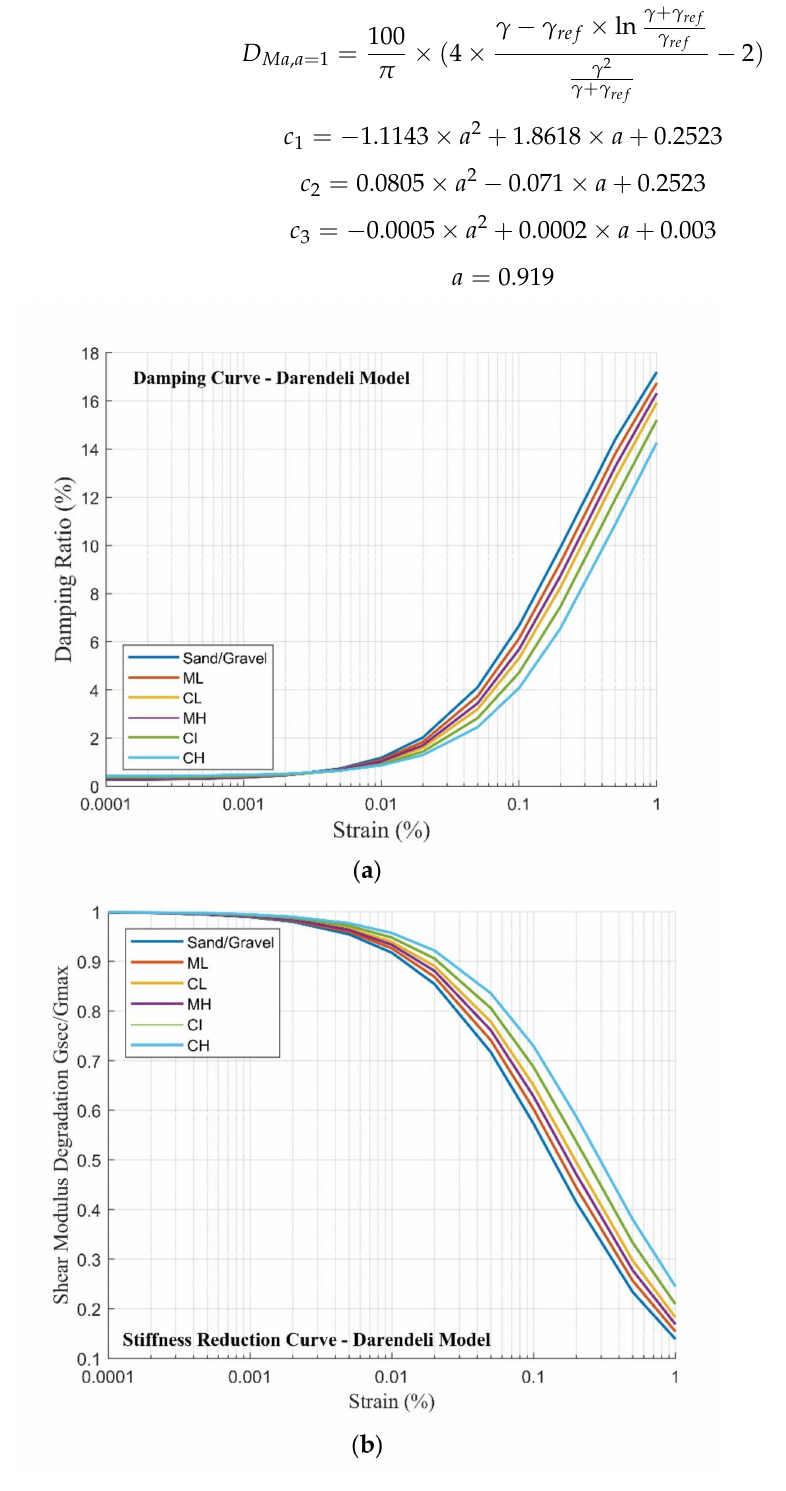
Figure A1. Dynamic properties of soils as per the Darendeli model: ( a ) damping curve; ( b ) stiffness reduction